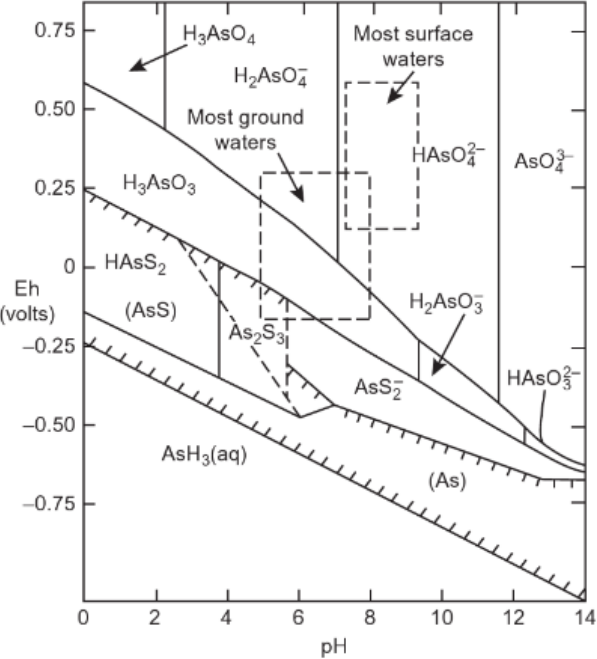
Figure 2. Eh – pH diagram of aqueous arsenic species in water at 25 °C and 1 bar total pressure [10]. Figure 2. Eh–pH diagram of aqueous arsenic species in water at 25 ◦ C and 1 bar total pressure